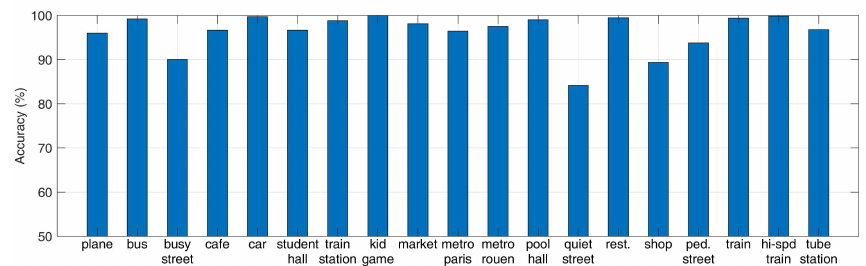
Figure 10. Classification accuracies for each scene category obtained by the proposed